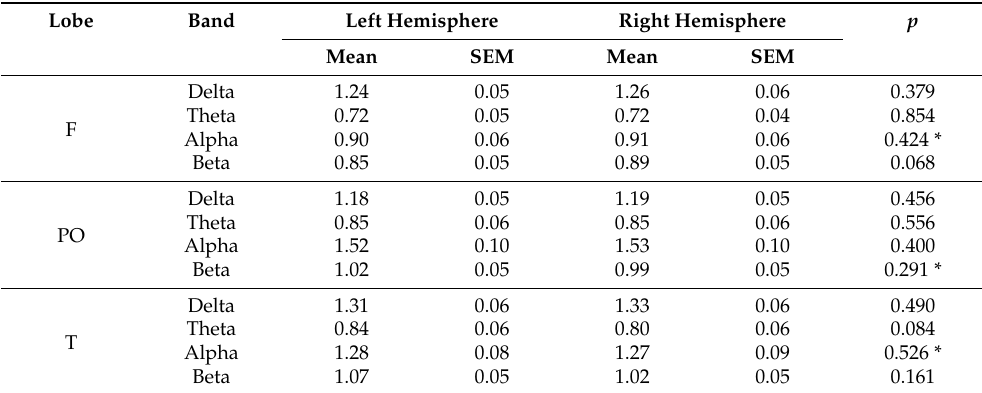
Table 2. Structure of the different lobes as function of groups of age. Data are ordered from the highest to lowest value of logPS for every lobe; therefore, the labels do not follow the same order. <20 YEARS ( N = 7) 20–50 Years ( N = 25) >50 Years ( N = 5) Lobe Left Right Left Right Left Right Band Mean SEM